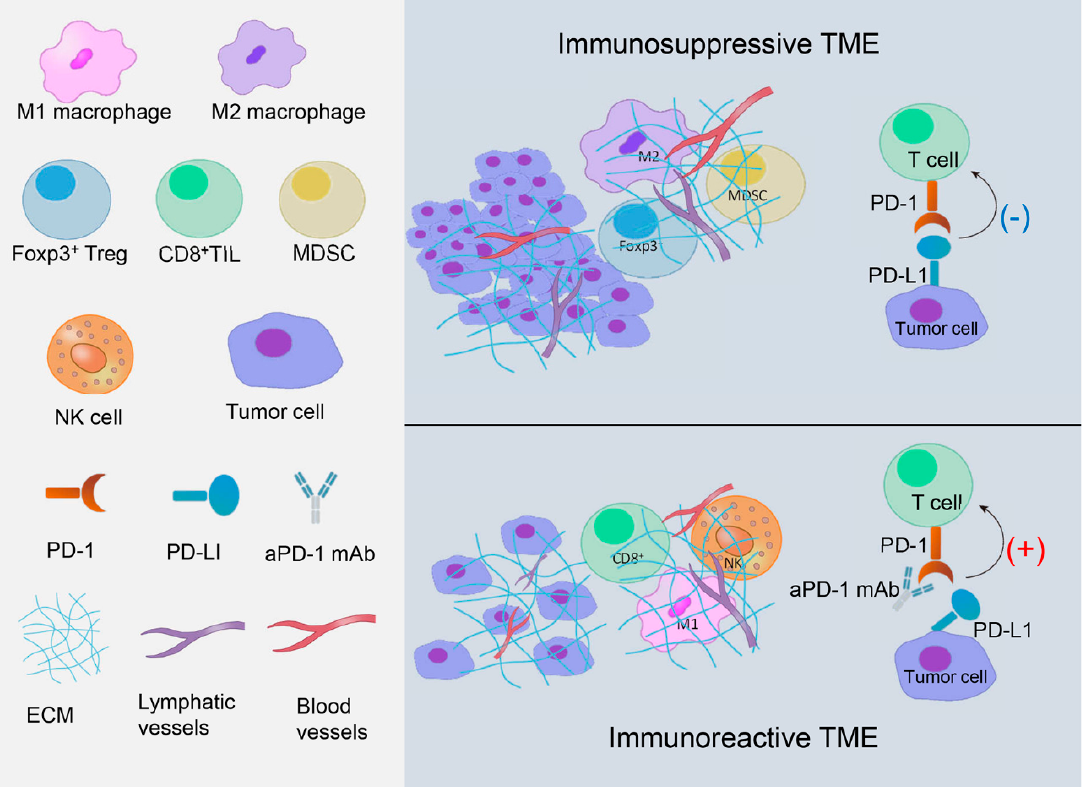
Figure 1. Immunosuppressive and immunoreactive TME. Immunosuppressive tumor microenvironment (TME) is mainly constituted of M2 macrophages, forkhead box P3 + (Foxp3 + ) regulatory T lymphocytes (Tregs), myeloid-derived suppressor cells (MDSCs), and PD-1/PD-L1 axis. Immunoreactive TME is mainly constituted of CD8 + T cells, natural killer (NK) cells, and M1 macrophages. PD-1/PD-L1 axis becomes immunoreactive in response to anti-PD1 or anti-PD-L1 monoclonal antibody (aPD-1/PD-L1 mAb) owing to the activation of CD8 + T cells. (Foxp3, forkhead box P3; Tregs, regulatory T lymphocytes; MDSC, myeloid-derived suppressor cell; NK, natural killer; PD-1, programmed cell death protein-1; PD-L1, programmed death-ligand 1; aPD-1 mAb, anti-PD-1 monoclonal antibody; ECM, extra cellular matrix; TME, tumor microenvironment).